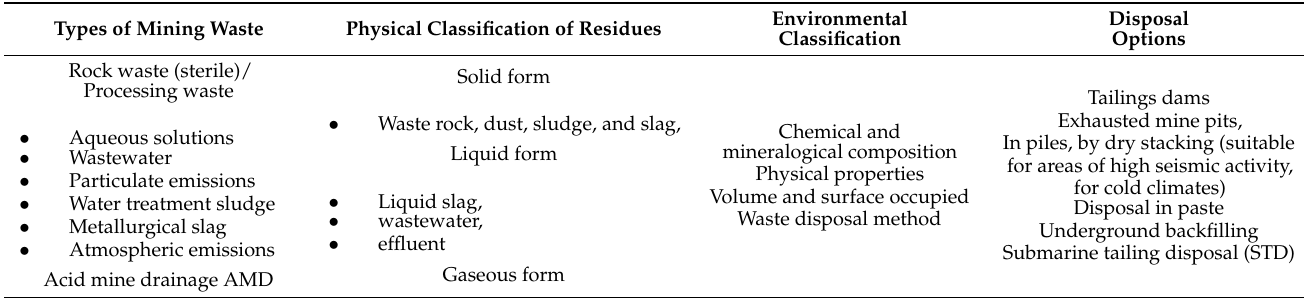
Table 1. Characterization of mining waste [30–33].